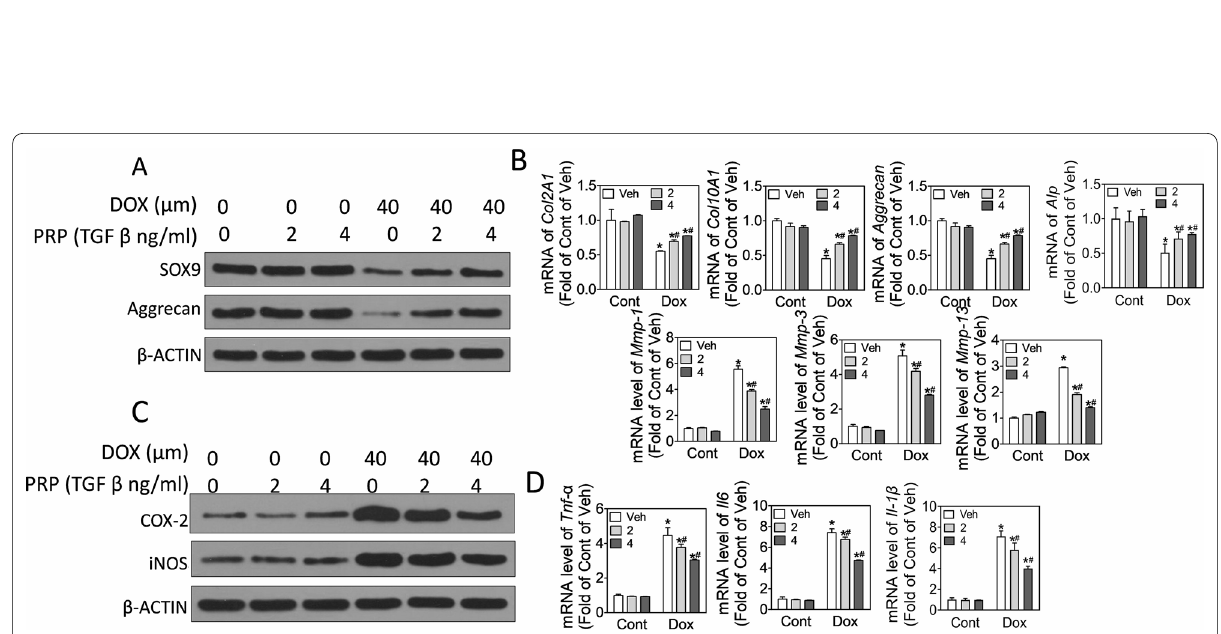
Fig. 3 PRP suppresses doxorubicin exposure-induced inflammation. ATDC5 cells were treated with PRP and doxorubicin for 24 h. A Western blot results showing the protein levels of SOX9, Aggrecan, and β-actin. B Real-time PCR to detect mRNA levels of Col2A1, Col10A1, Aggrecan, ALP, MMP-1, MMP-3, and MMP-13. C Western blot to exam the protein levels of inflammatory factors COX-2 and iNOS, and β-actin. D Real-time PCR to detect mRNA levels of TNF-α, IL-6, and IL-1β. At least three independent experiments were performed. * p < 0.05 vs control of the same doxorubicin treatment; # p < 0.05 vs vehicle of the same TGFβ